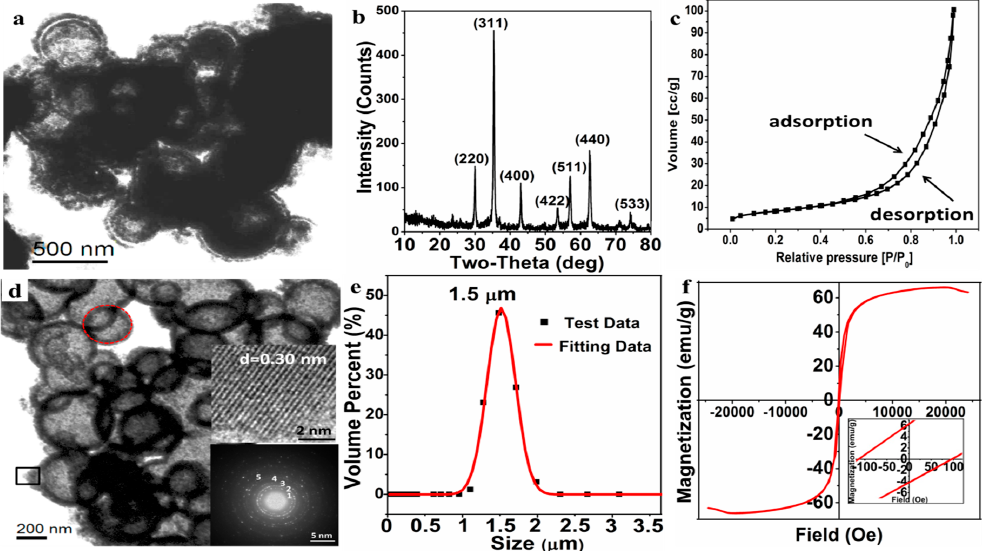
Figure 7. TEM image of I 0.0525 before calcination ( a ); XRD pattern ( b ); nitrogen adsorption-desorption curves ( c ); TEM image ( d ); particle size distribution ( e ); and magnetic hysteresis loop ( f ) of macroporous Fe 3 O 4 microparticles F 0.0525 after calcination.